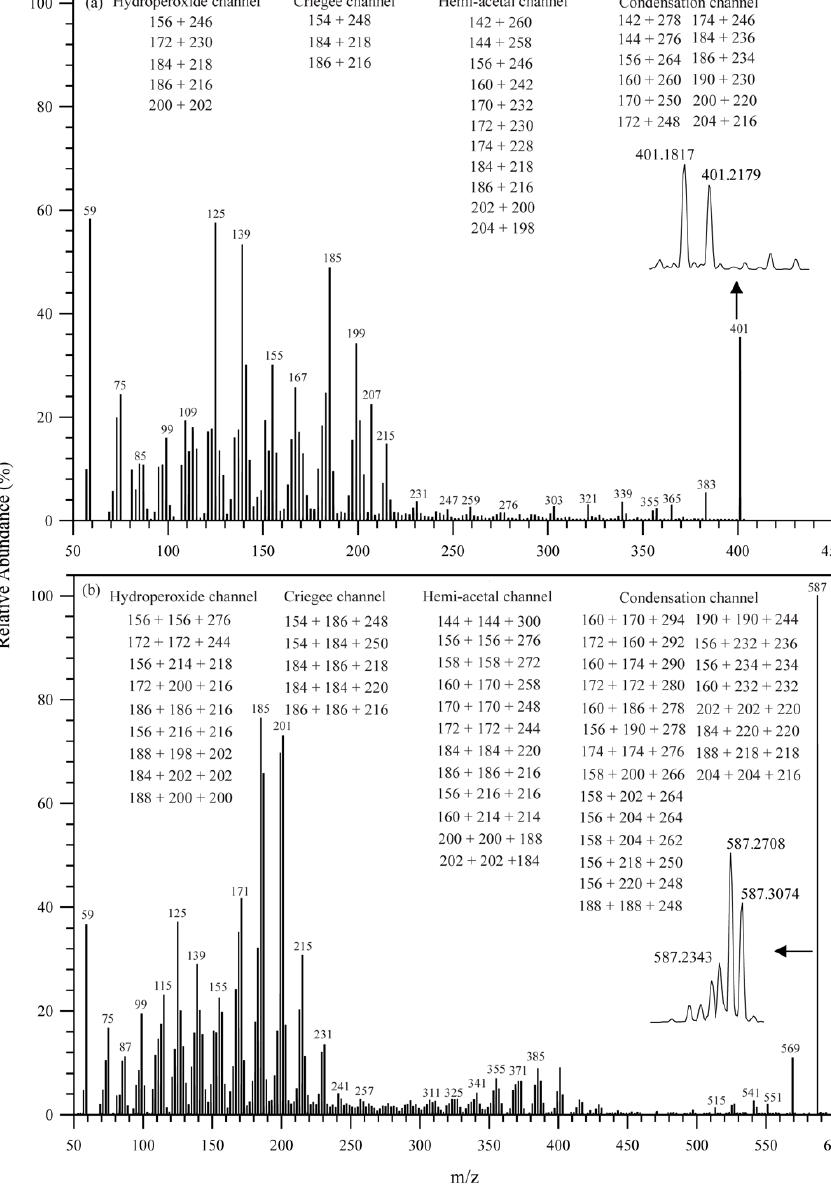
(Group I, II, III, and IV). The observed homologous